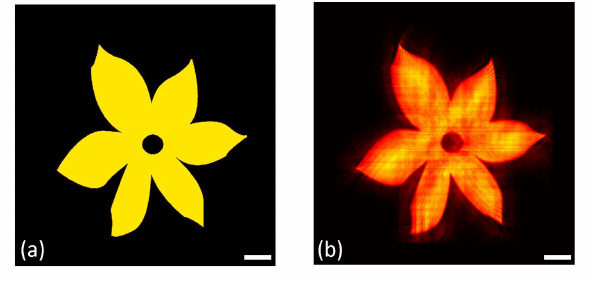
Figure 5. Experimental results with object scanned. ( a ) The target and ( b ) the reconstructed image using our method. Scale bar: 1